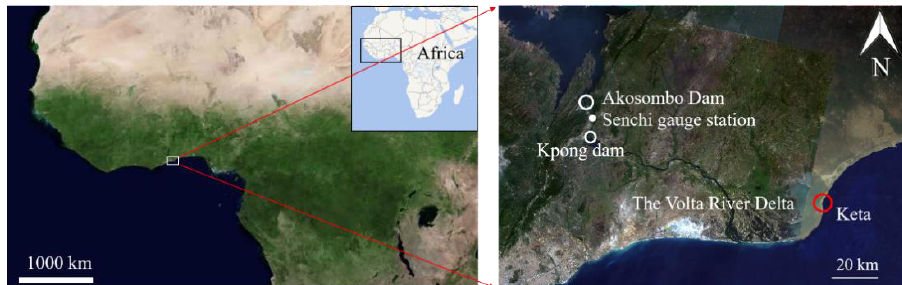
Figure 1. The location of the Volta River Delta.